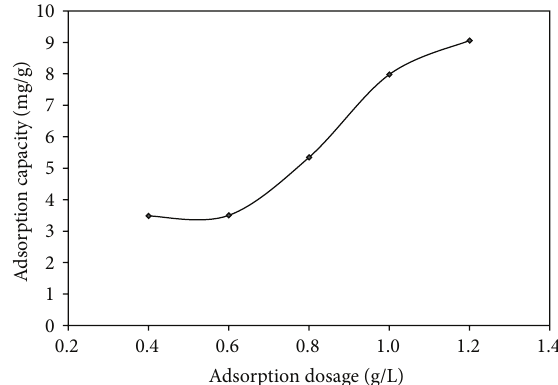
Figure 5: Effect of adsorbent dosage on the adsorption of RhB onto